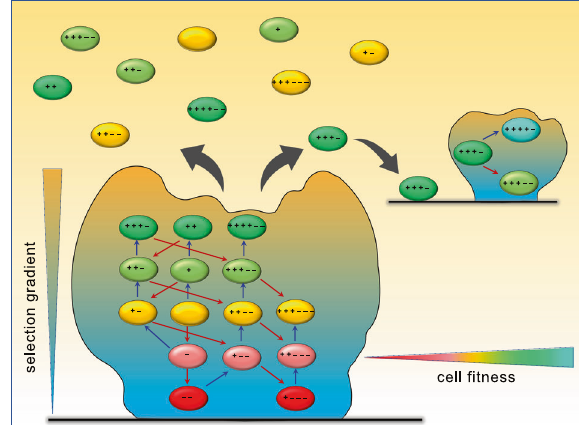
Fig. 2 A simpli fi ed schematic illustrating the concept of bio fi lms as diversity incubators, and the dynamic process of diversity generation in bio fi lms. The bio fi lm mode of life and external stressors stimulate the generation of mutations in bio fi lm cells. The selection gradient that forms as a result of external stressors acts differentially on the various layers of cells. This allows the sequential generation of increasingly fi t phenotypes under multiple rounds of mutation and increasing selection pressure. Cells with decreased fi tness (as a result of initial mutations) can survive within the protective bio fi lm environment and accumulate mutations that can restore, or even increase their fi tness. Upon dispersal from the parent bio fi lm, cells with decreased fi tness perish without the protective shield of the bio fi lm, whereas cells with increased fi tness have the potential to establish new bio fi lm communities where the further evolution of fi tness can occur. Mutations leading to an increase in fi tness are indicated by blue arrows followed by a ‘ + ’ sign, mutations leading to decreased fi tness are indicated by red arrows and a ‘ − ’ sign. A limited number of variations is